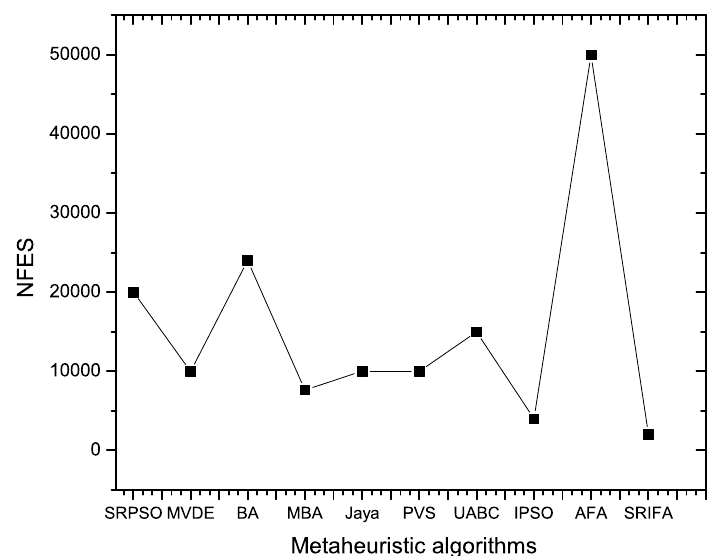
Figure 6. NIAs with NFEs for the tension/compression problem.